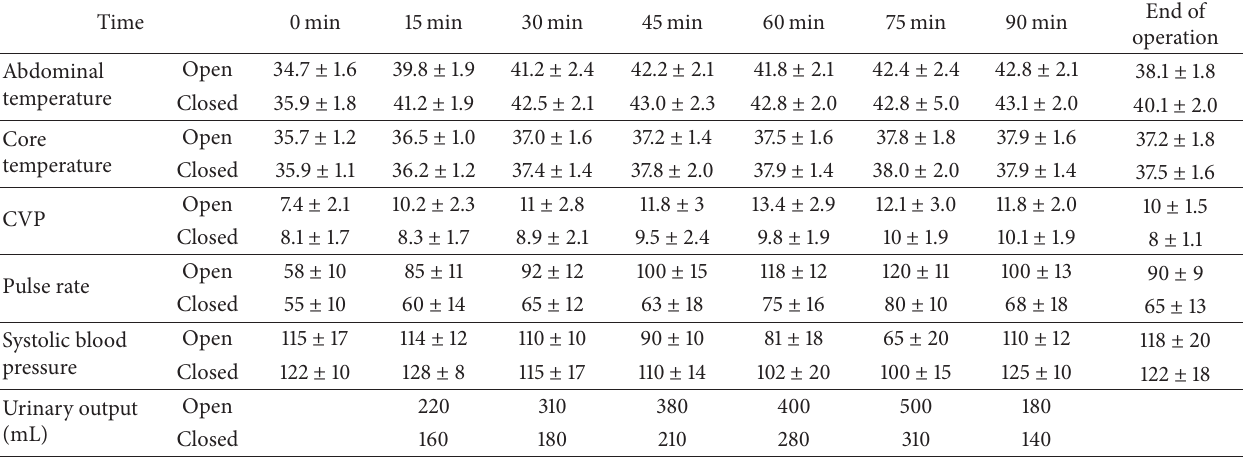
Table 4: Haemodynamic parameters during